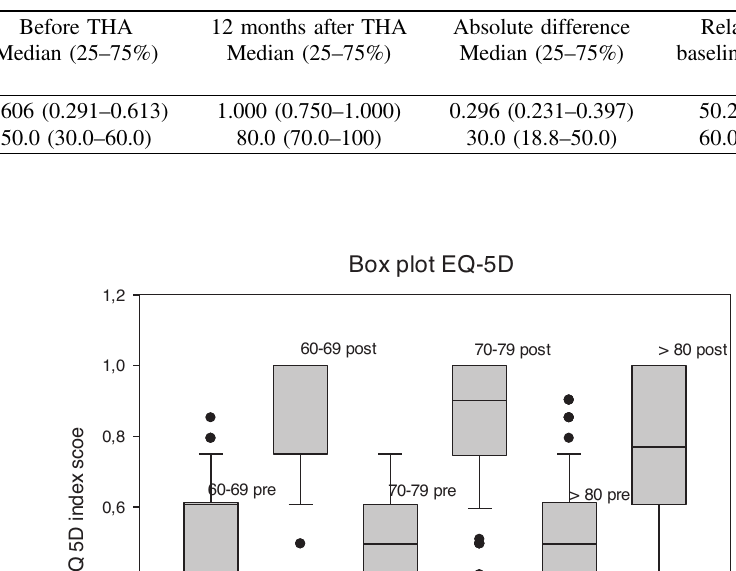
Table 10. EQ-5D index score and VAS before and after THA in the group 60 – 69.